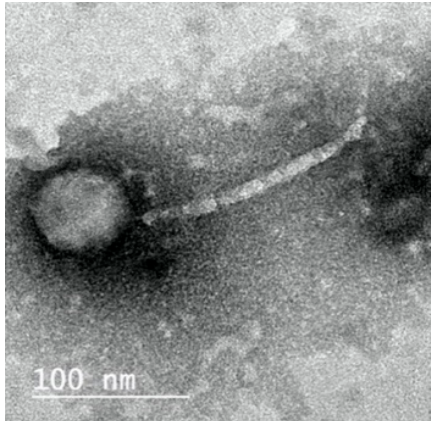
Figure 1. Transmission electron microscopic image of phage ZCKP8.